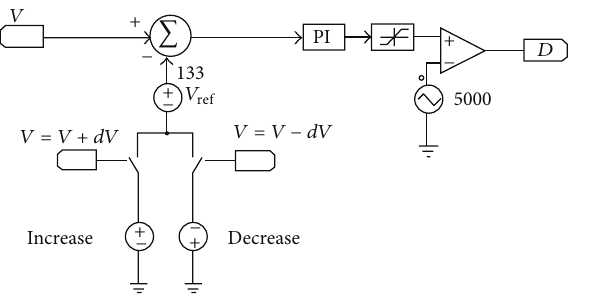
Figure 10: Implementation of IC technique.